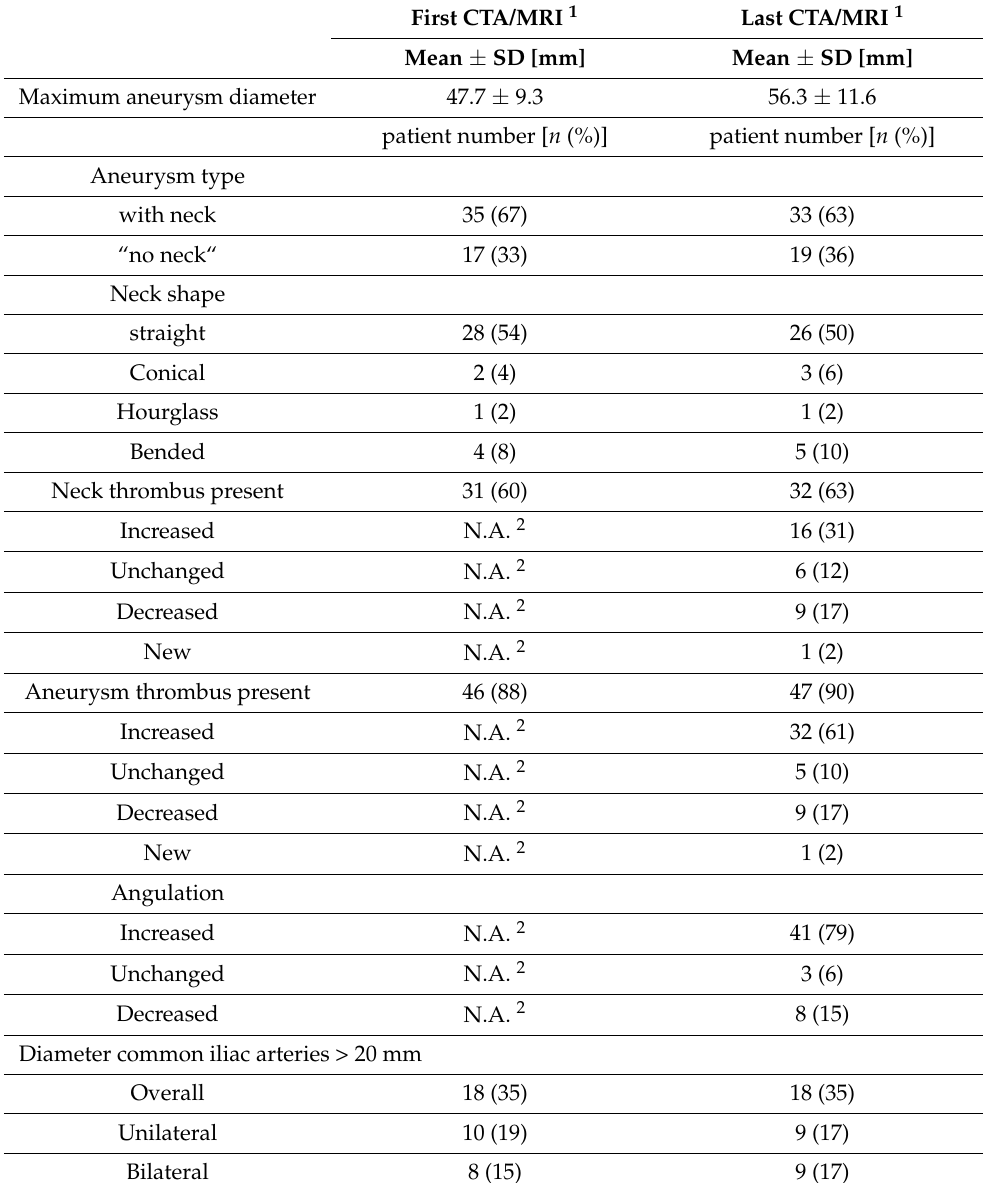
Table 3. Results of morphological parameter